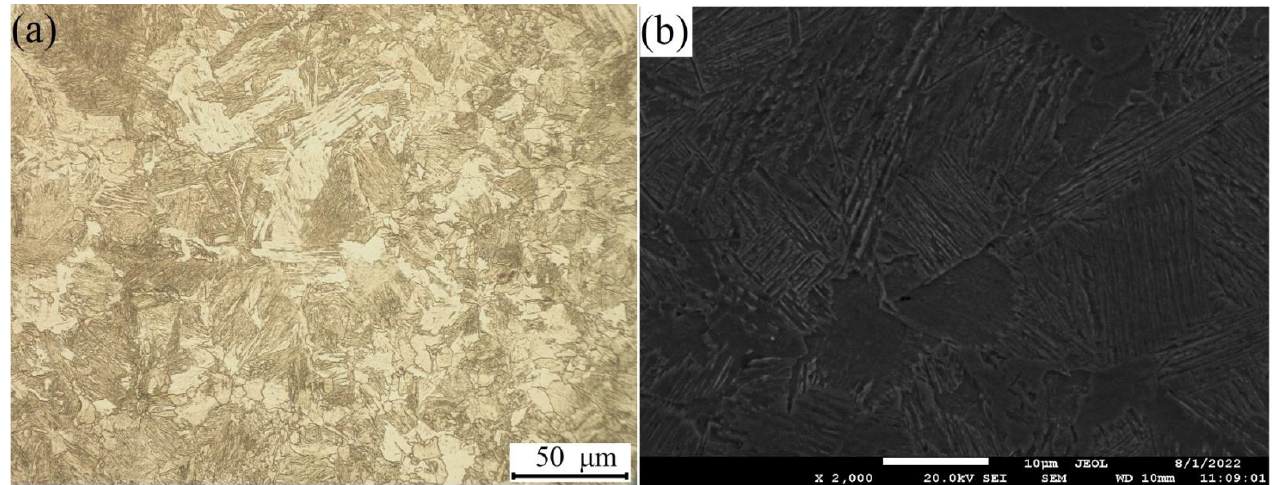
Figure 5. The microstructure of the FGHAZ: ( a ) OM; ( b ) SEM.